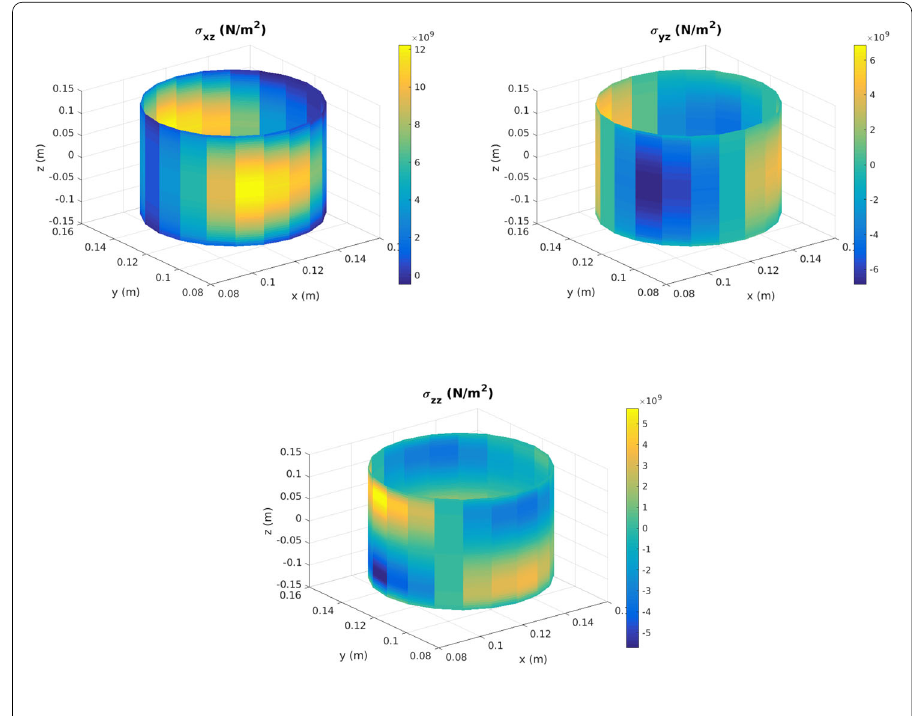
Fig. 5 Out-of-plane stress tensor components around the hole using the minimally-intrusive fully 3D separated plate formulation